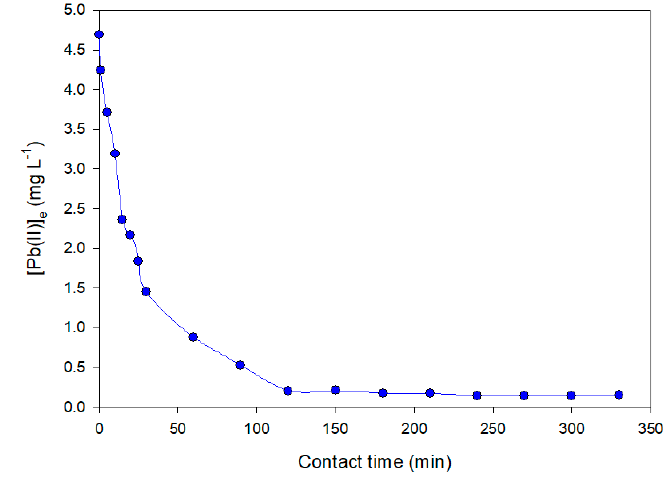
Figure 7. Pb(II) adsorption in continuous mode using aminated poly(ethylene terephthalate) (APET) nanofiber mats.